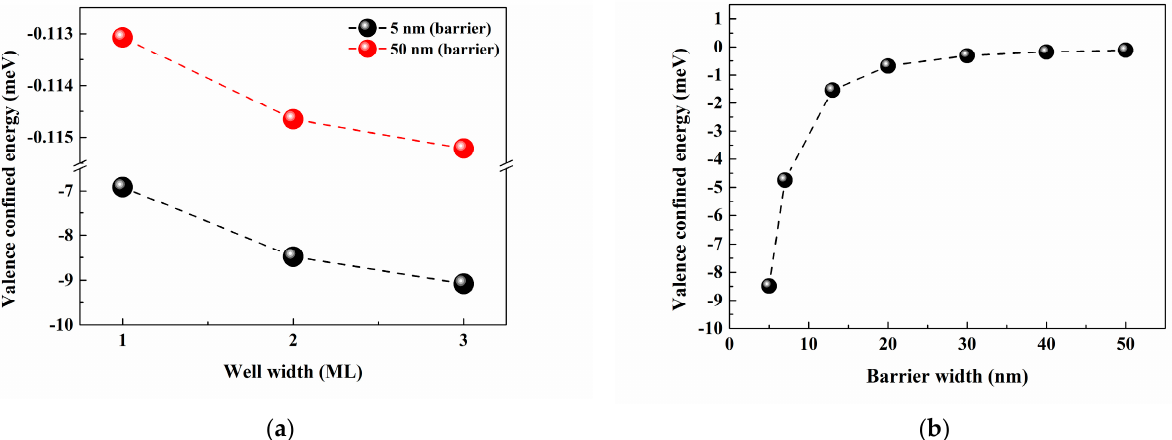
Figure 4. Variations of valence − confined energies for ( a ) different well and barrier widths and ( b ) 2 MLs well width and different barrier widths. ( b ) 2 MLs well width and different barrier